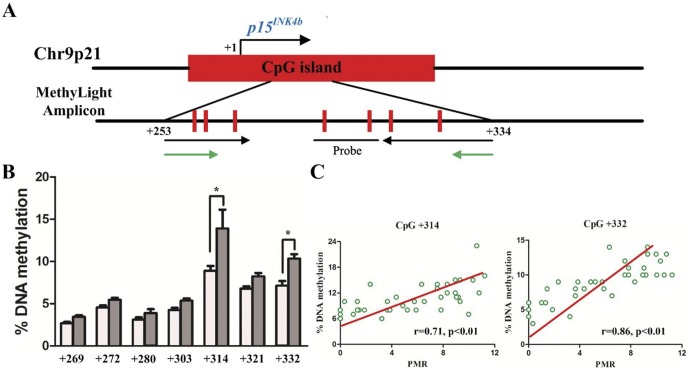
Pyrosequencing to identify the methylated CpG sites of p15INK4b.A. Schematic diagram of the CpG island within p15INK4b. Seven CpG sites detected by pyrosequencing are indicated in red. Black and green arrows indicate the PCR primer pairs of MethyLight and pyrosequencing respectively. B. DNA methylation levels at each CpG site in percentage are analyzed by pyrosequencing in 22 randomly selected controls (white bar) and 22 CAD patients (grey bar). Date are presented as mean ± SD. * p<0.05 vs. controls. C. Correlation of p15INK4b methylation levels measured by MethyLight and pyrosequencing at CpG +314 and +332. Correlation efficient (r) and p value as indicated.